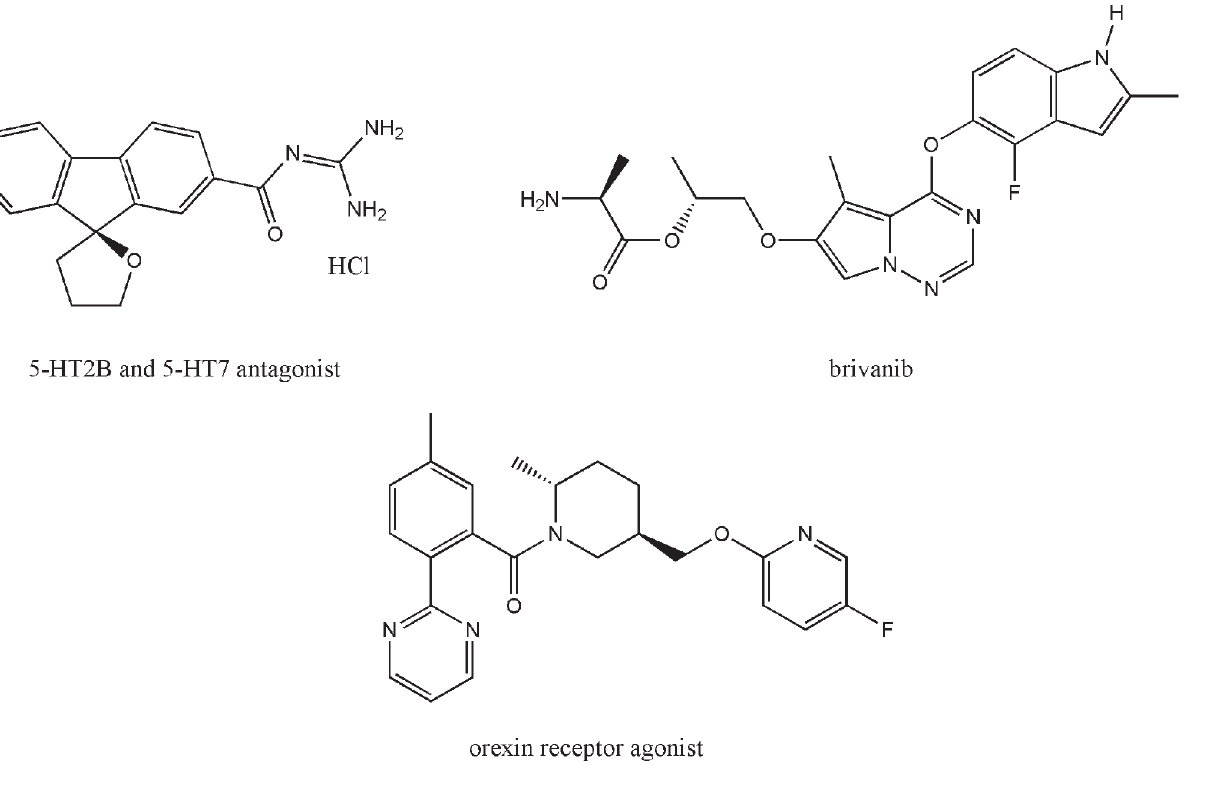
Figure 1: Chemical structures of the three pharmaceuticals examined in this